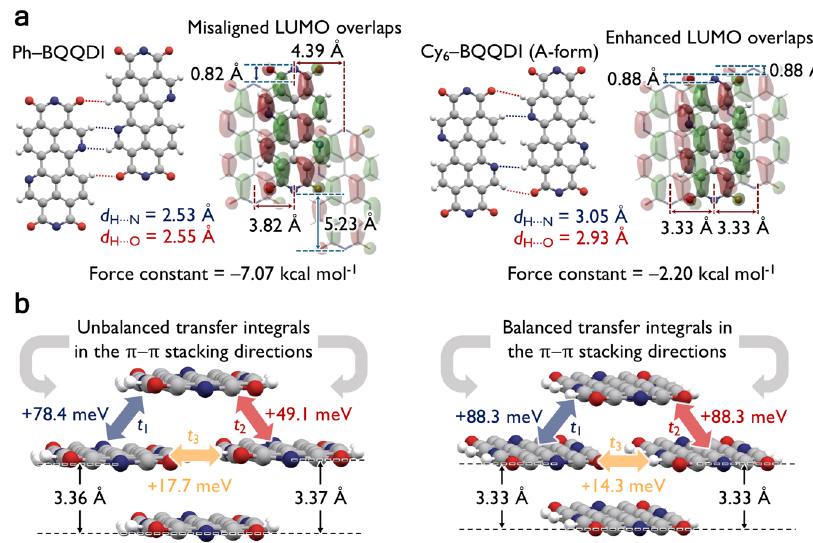
Fig. 3 Molecular assemblies and charge-transport capabilities of Ph – BQQDI and Cy 6 – BQQDI. a Intermolecular distances and force constants between dimers along the transverse direction, molecular misalignment distances, and illustration of LUMO overlaps along the π – π stacking direction. b Illustration of the 2D brickwork molecular assembly, including π – π stacking distances (between planes of atoms on the BQQ core, excluding hydrogens) and the calculated transfer